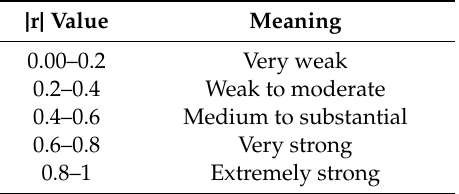
Table 6. Significance of regression coe ffi cient (r).